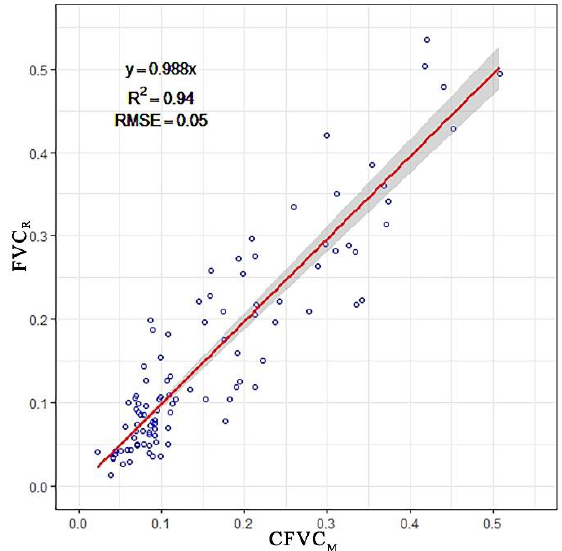
Figure 7. Linear relationships between FVC R and CFVC M .